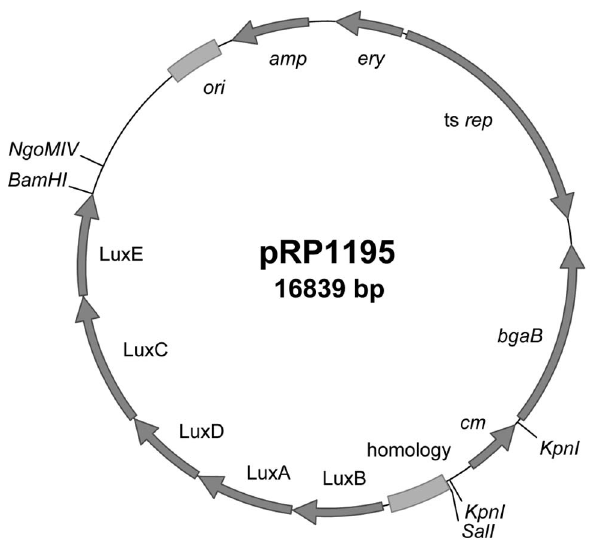
Figure 1. Map of integrative plasmid pRP1195. Features added to the pMAD backbone as described in Materials and Methods include: cm , chloramphenicol resistance gene; homology, PCR fragment in the area of pseudogene USA300_HOU1102 amplified from NRS384; LuxB, A, D, C, and E, modified lux operon from Photorhabdus luminescens .